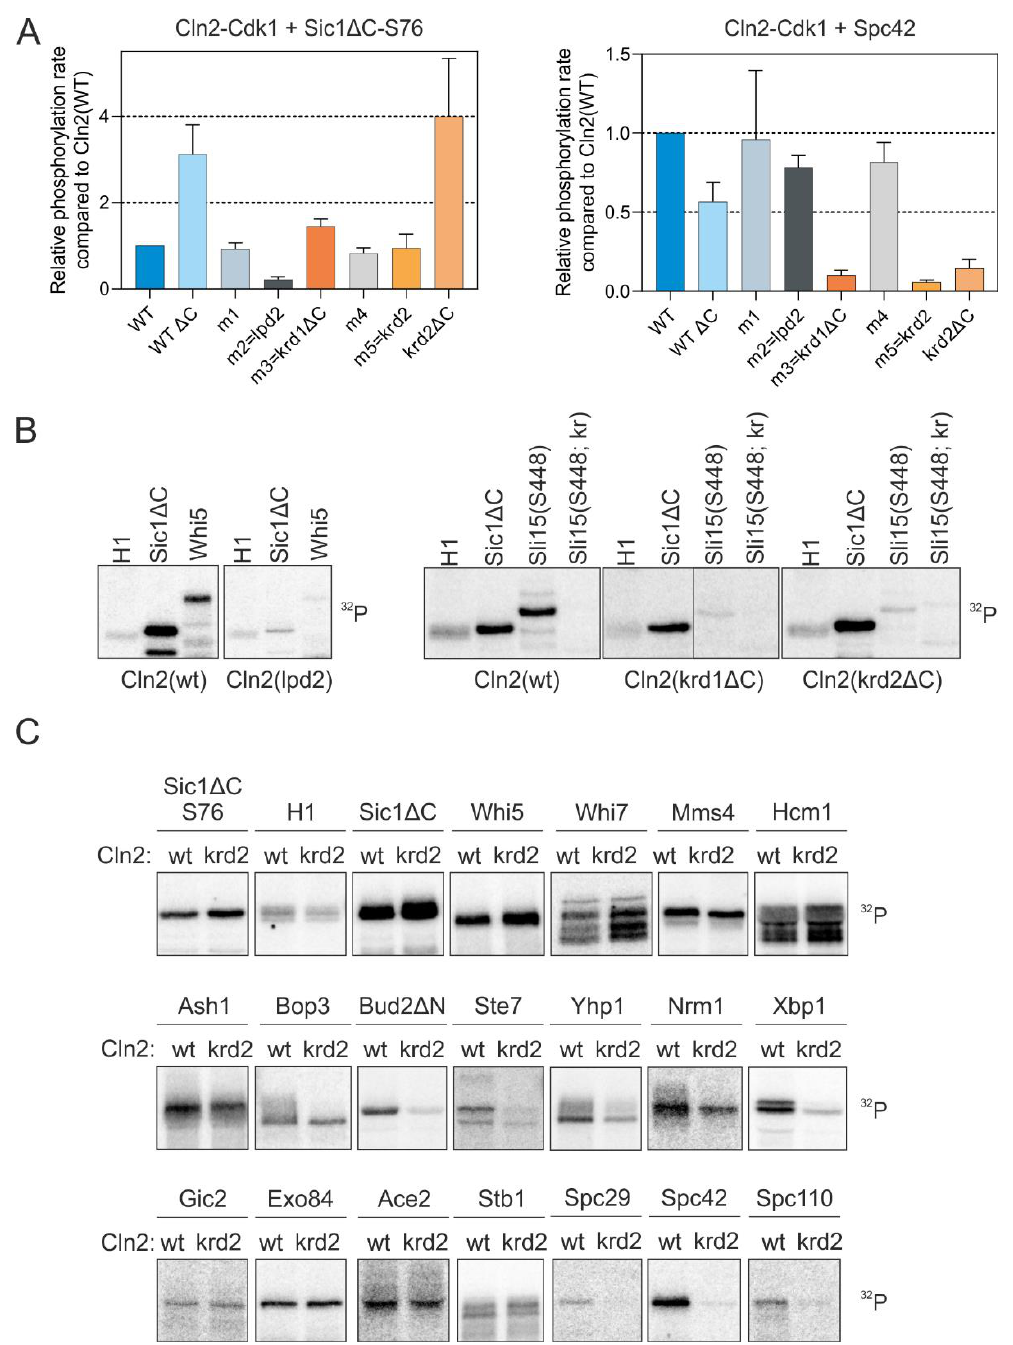
Figure 3. Cln2 mutants deficient in either LP or K/R docking. ( A ) The docking specificity of mutant Cln2-Cdk1 complexes was analyzed in vitro by measuring phosphorylation of LP-dependent substrate Sic1-S76 and K/R-dependent Spc42. The mutations in each Cln2 mutant and their position on the Cln2 surface are shown in Figure S2A,B. Cln2- ∆ C indicates deletion of the C-terminal intrinsically disordered domain of Cln2 (positions 372–545). ( B ) 32 P-autoradiographs showing the phosphorylation of histone H1, Sic1 ∆ C, Whi5, Sli15(421–511 S448) and Sli15(421–511 S448; kr), where the basic residues involved in K/R docking (highlighted in Figure 2B) are mutated to Q and N, by different Cln2-Cdk1 mutant complexes. ( C ) The effect of K/R docking on phosphorylation of various G1-Cdk1 targets was studied in vitro using Cln2(krd2) mutant. Representative 32 P-autoradiographs are shown.